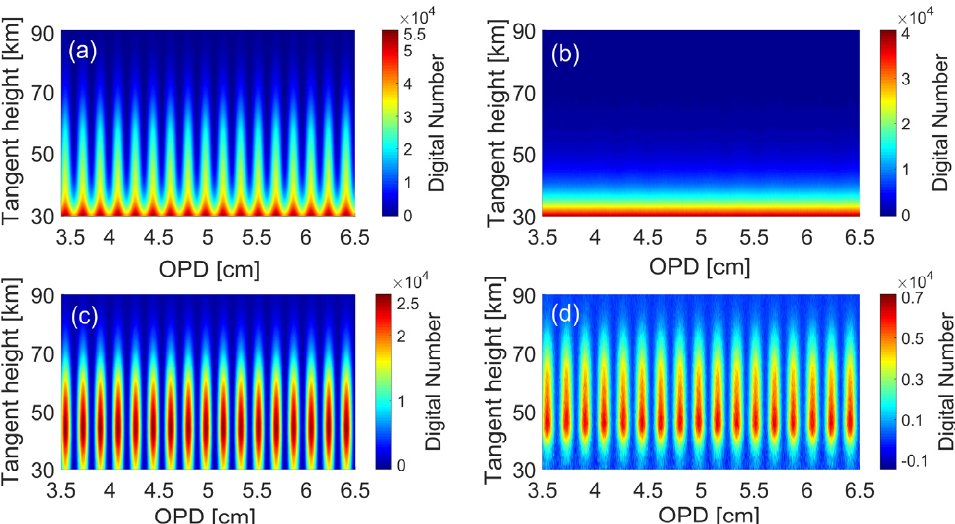
Figure 10. The process of retrieving the interferogram containing information solely from the target altitude. ( a ) The combined signal image (sum of airglow emission and scattering atmospheric signals) with noise added; ( b ) the scattering atmospheric signal image; ( c ) the recovered (scattering signal subtracted) atmospheric signal image; ( d ) the recovered atmospheric signal image after unraveling the LOS integration.